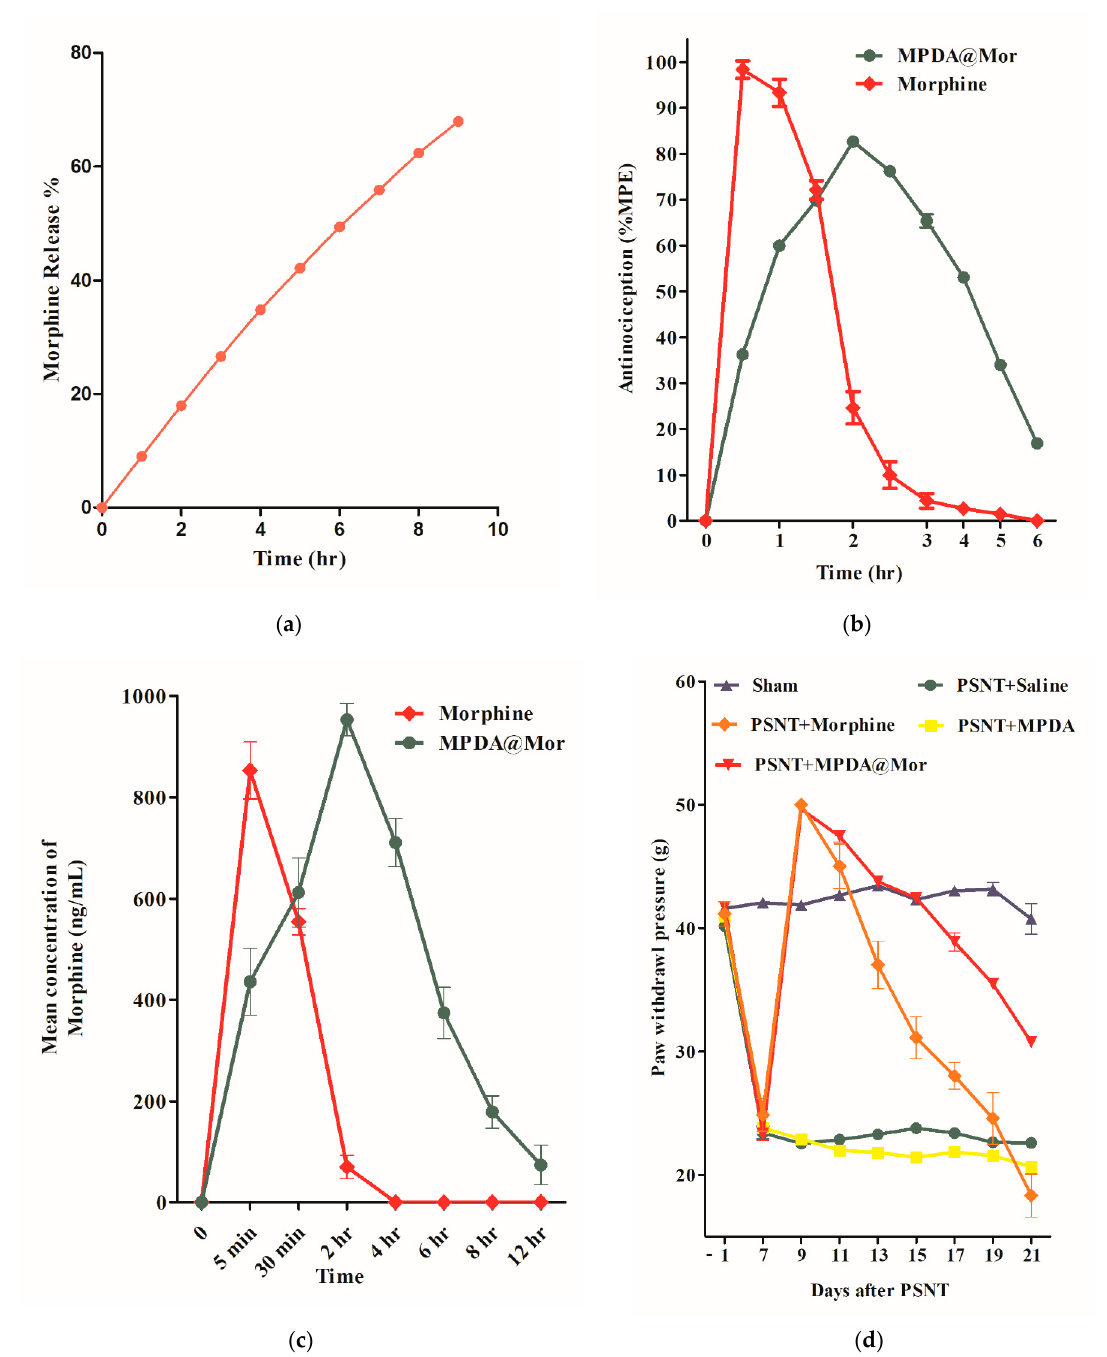
Figure 6. ( a ) Cumulative morphine release from MPDA@Mor in normal saline (pH 7.2). ( b ) Antinociceptive effect as a function of time after a single intraperitoneal injection of 15 mg/kg morphine and MPDA@Mor. The intensity of analgesia is expressed as % of maximal possible effect (MPE). ( c ) Pharmacokinetic profile of morphine and MPDA@Mor. ( d ) Effect of daily intraperitoneal (i.p) injection of either saline or morphine or MPDA@Mor on morphine antinociceptive tolerance (MAT) in sham or partial sciatic nerve transection rats. Differences between paw withdrawal threshold to tactile stimuli in rats with sham surgery (N = 6) and PSNT were assessed before nerve transection on the day of surgery (indicated as day − 1 on the x -axis) and on day 7 after nerve transection. After PSNT, significant tactile sensitivity developed on day 7. The effect of MPDA, morphine, and MPDA@Mor on the mechanical paw withdrawal threshold was measured 60 min post i.p injection from days 9 to 21 after PSNT. p < 0.01.